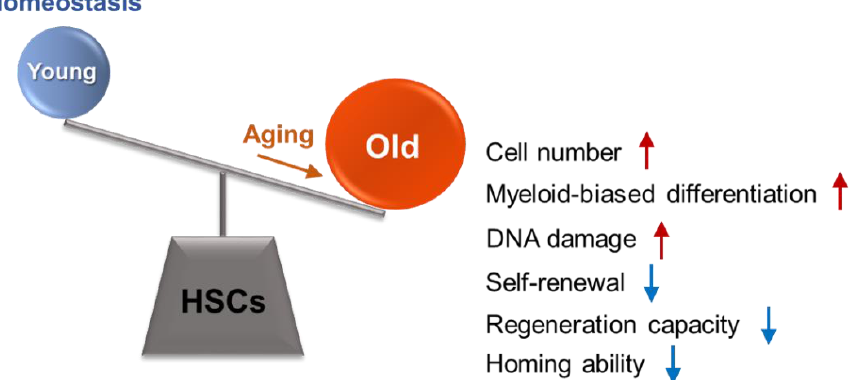
Figure 1. General phenotypes of aged hematopoietic stem cells (HSCs). Aged HSCs show increased cell number, myeloid-biased differentiation, DNA damage accumulation, reduced self-renewal, reduced regeneration capacity, and reduced homing ability compared with young HSCs.